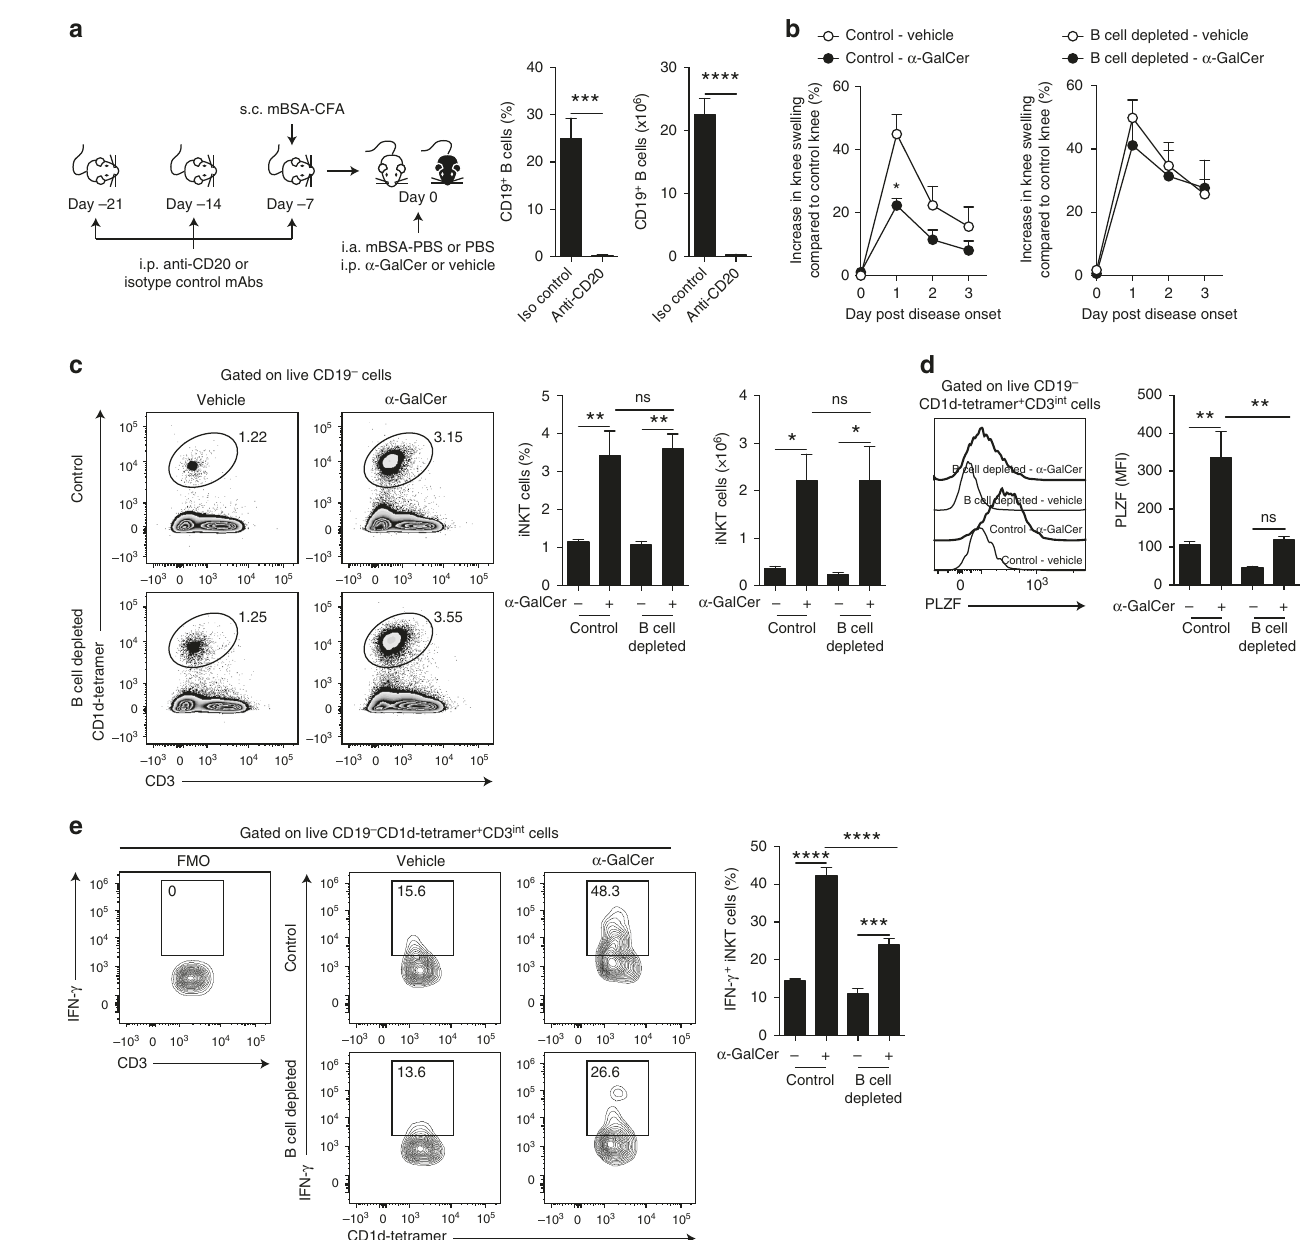
Fig. 2 B cell depletion abrogates the protective effect of α -GalCer on arthritis. a Left, schematic showing the experimental design for B cell depletion. Right, bar charts showing the frequency and number of splenic CD19 + B cells in B cell-depleted and isotype-control-treated WT mice prior to α -GalCer or vehicle administration ( n = 5 per group, one of three experiments is shown). b Mean clinical score of isotype-control-treated WT mice (left) and B cell-depleted WT mice (right) that received α -GalCer or vehicle alone following induction of arthritis. The Y axis shows the percentage of swelling in antigen-injected knee compared to control knee ( n = 5 per group, one of two experiments is shown). c Representative fl ow cytometry plots and bar charts showing the frequency and number of splenic iNKT cells in B cell-depleted and isotype-control-treated WT mice that received α -GalCer or vehicle alone ( n = 5 per group, one of two experiments is shown). d Representative histograms and bar chart showing MFI of PLZF in splenic iNKT cells in B cell-depleted and isotype-control-treated WT mice that received α -GalCer or vehicle alone ( n = 3 per group, one of two experiments is shown). e Representative fl ow cytometry plots and bar chart showing the frequency of IFN- γ + splenic iNKT cells in B cell-depleted and isotype-control-treated WT mice that received α - GalCer or vehicle alone ( n = 4 per group, one of two experiments is shown). c Analyzed on day 3 post disease onset; d , e analyzed at 16 h post disease onset. Data are mean ± s.e.m. ns not signi fi cant, * p < 0.05, ** p < 0.01, *** p < 0.001, and **** p < 0.0001 ( a Student ’ s t test, b two-way ANOVA, and c – e one-way